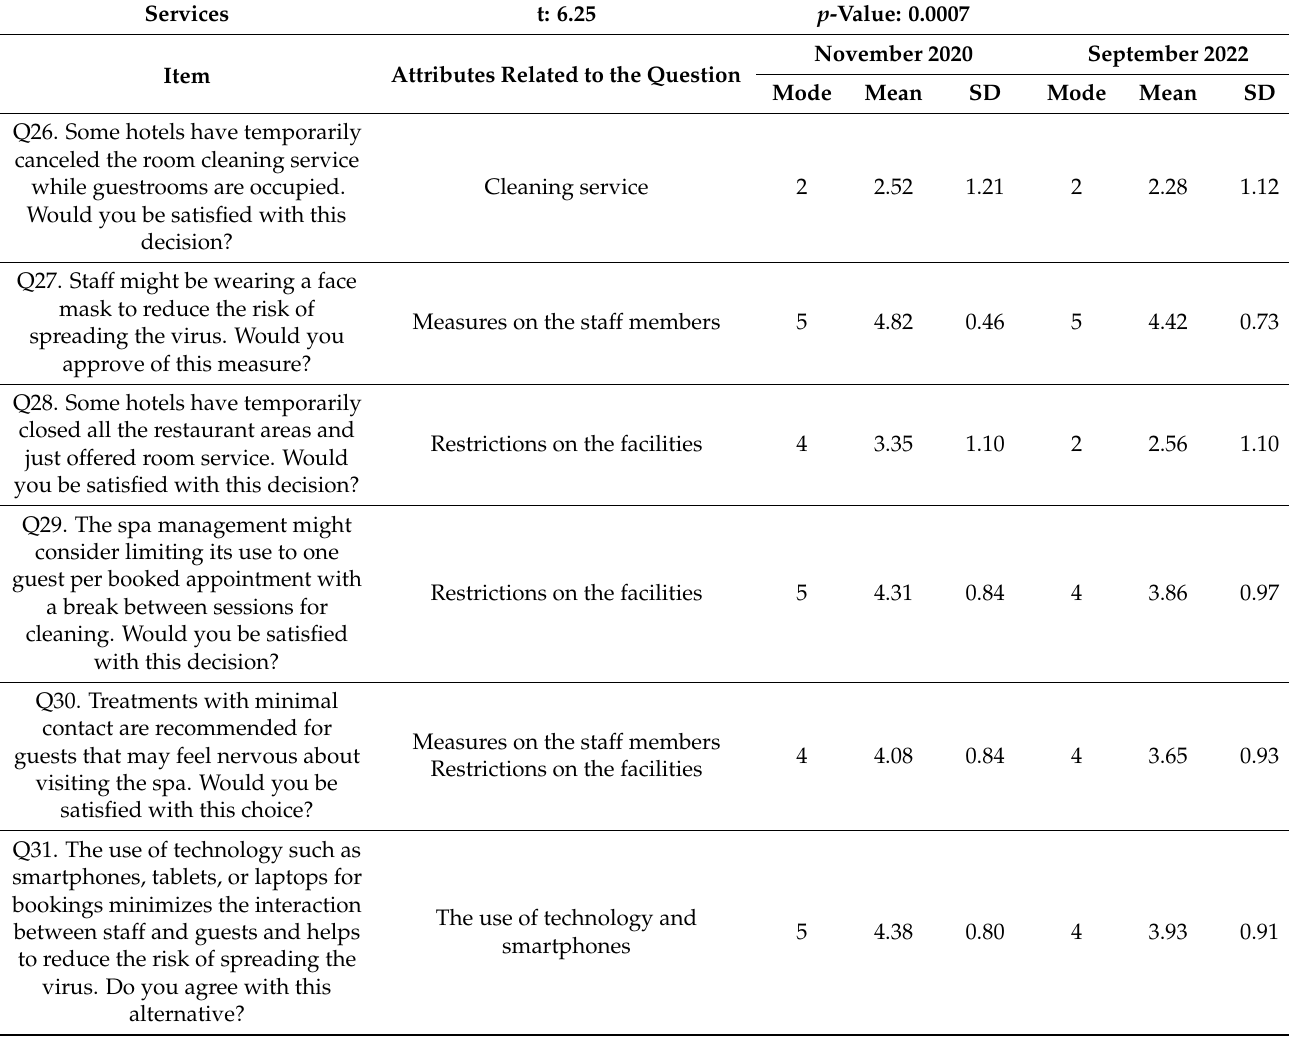
Table 7. Interval data analysis of the Services